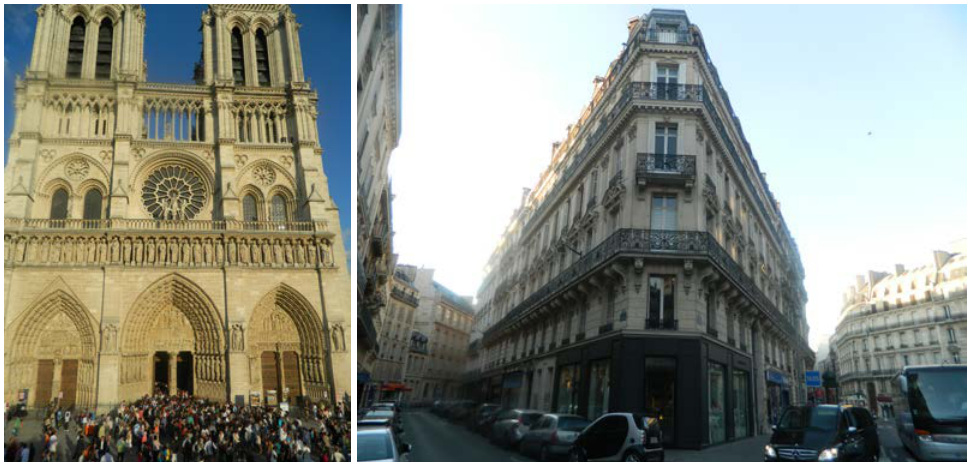
Figure 12: France, Paris – (left) Notre Dame Cathedral; (right) The streets of Paris and their related landscapes